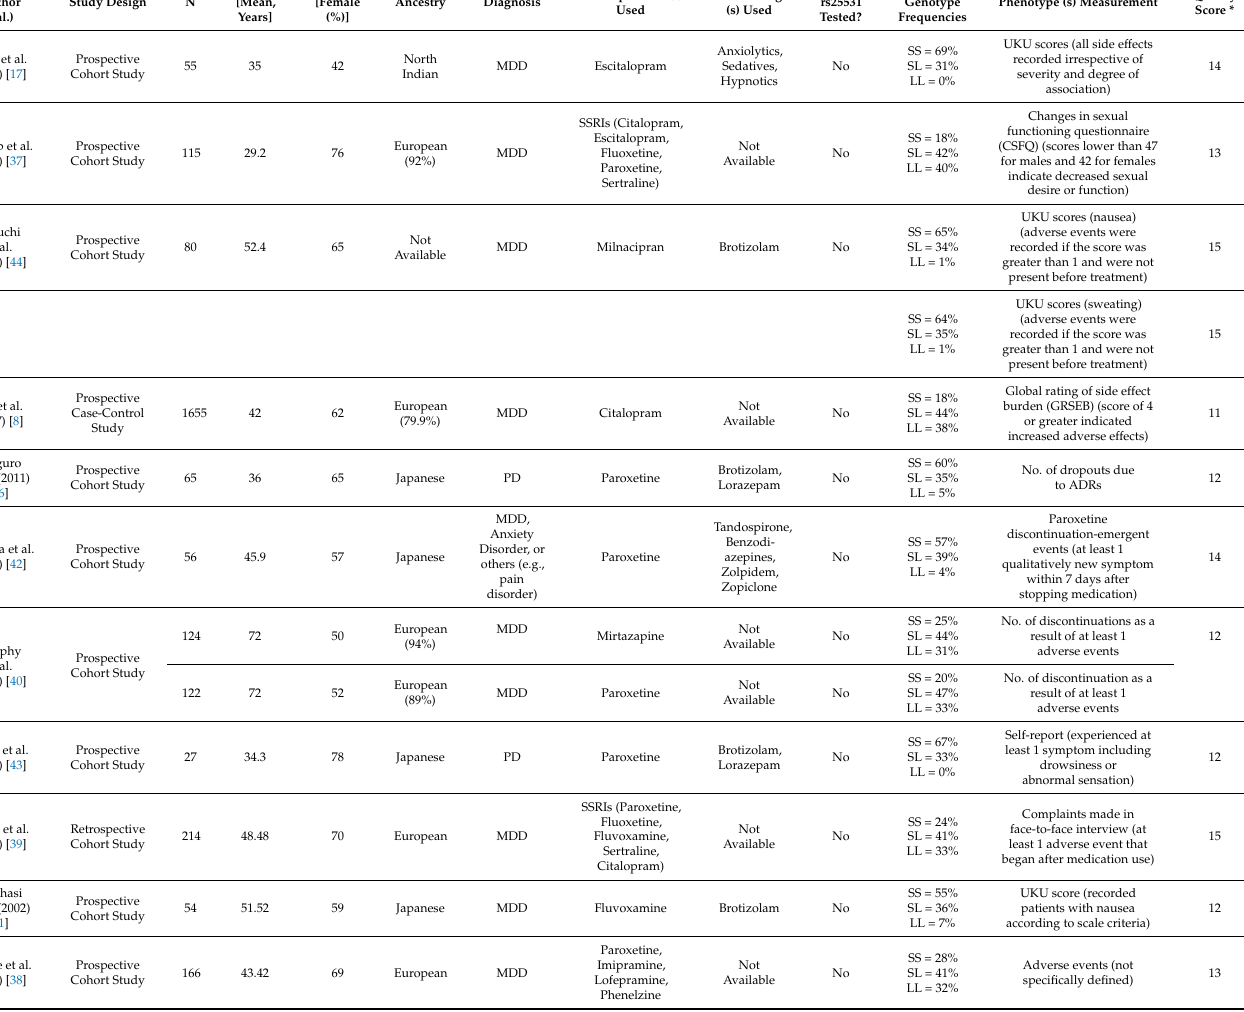
Table 3. Characteristics of studies ( n = 11) included in the meta-analysis on antidepressant tolerability. Study (Author